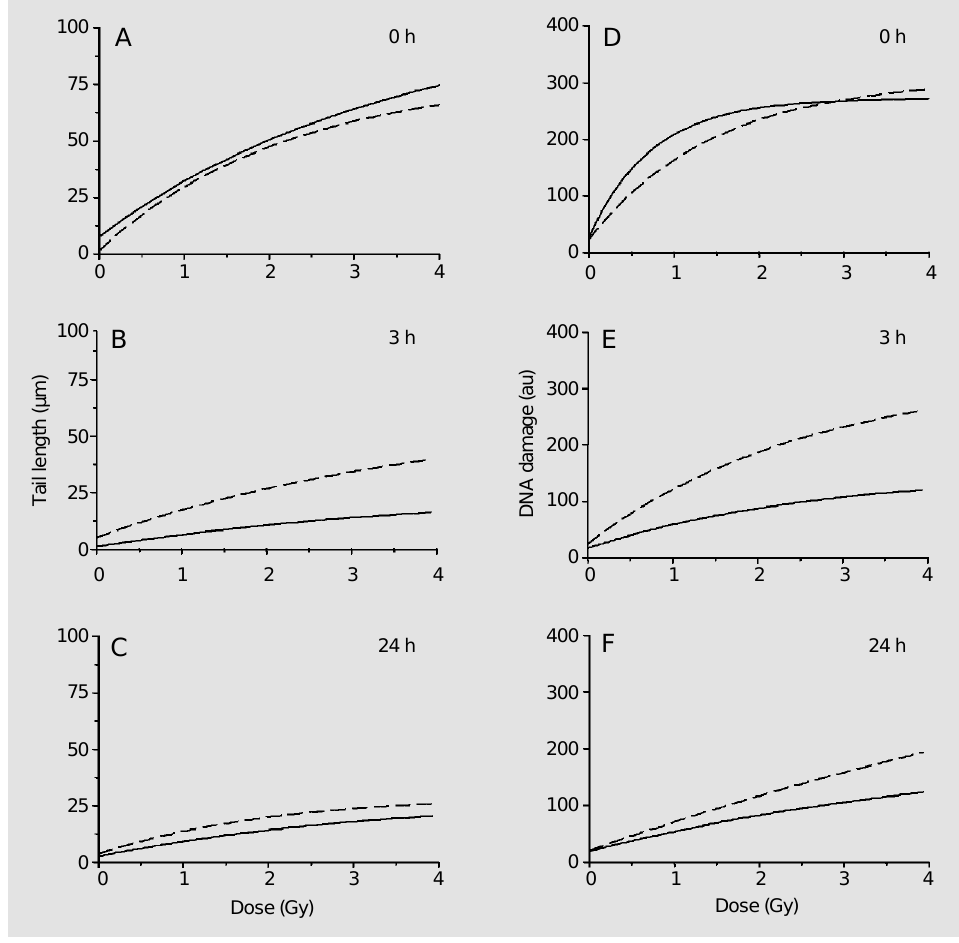
Figure 1 - Dose-response curves of DNA migration obtained for blood samples from 3 healthy donors (full lines) and 3 breast cancer patients (broken lines), processed immediately (A, D) or 3 (B, E) and 24 h (C, F) after in vitro exposure to 60